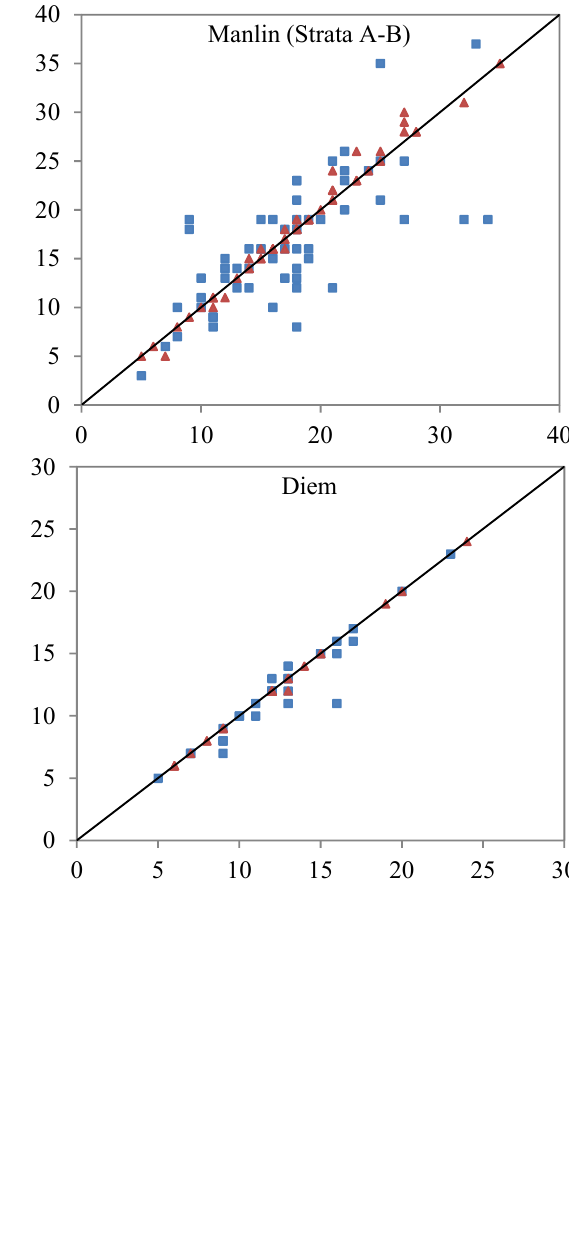
Figure 2. Relationship between the number of trees in each plot ( n trees/plot) recorded by community members and foresters (with same units on y -axes as on x -axis and y = x lines; n = 289 permanent plots) over the two separate rounds of monitoring year 1 (blue square) and year 2 (red triangle); each point in the graphs represents one census of the number of trees in the plot by foresters ( x -axis) and community members ( y